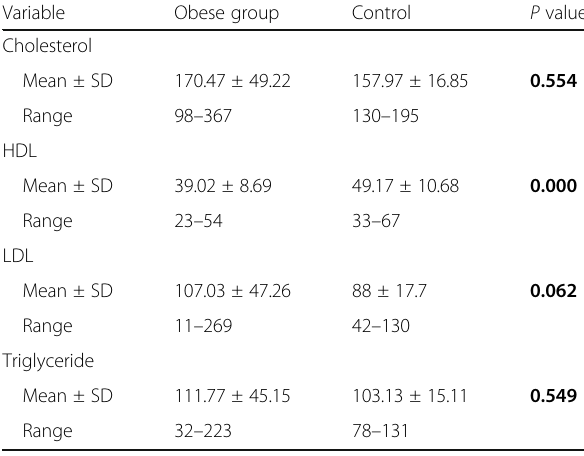
Table 4 Lipid profile in obese versus control group